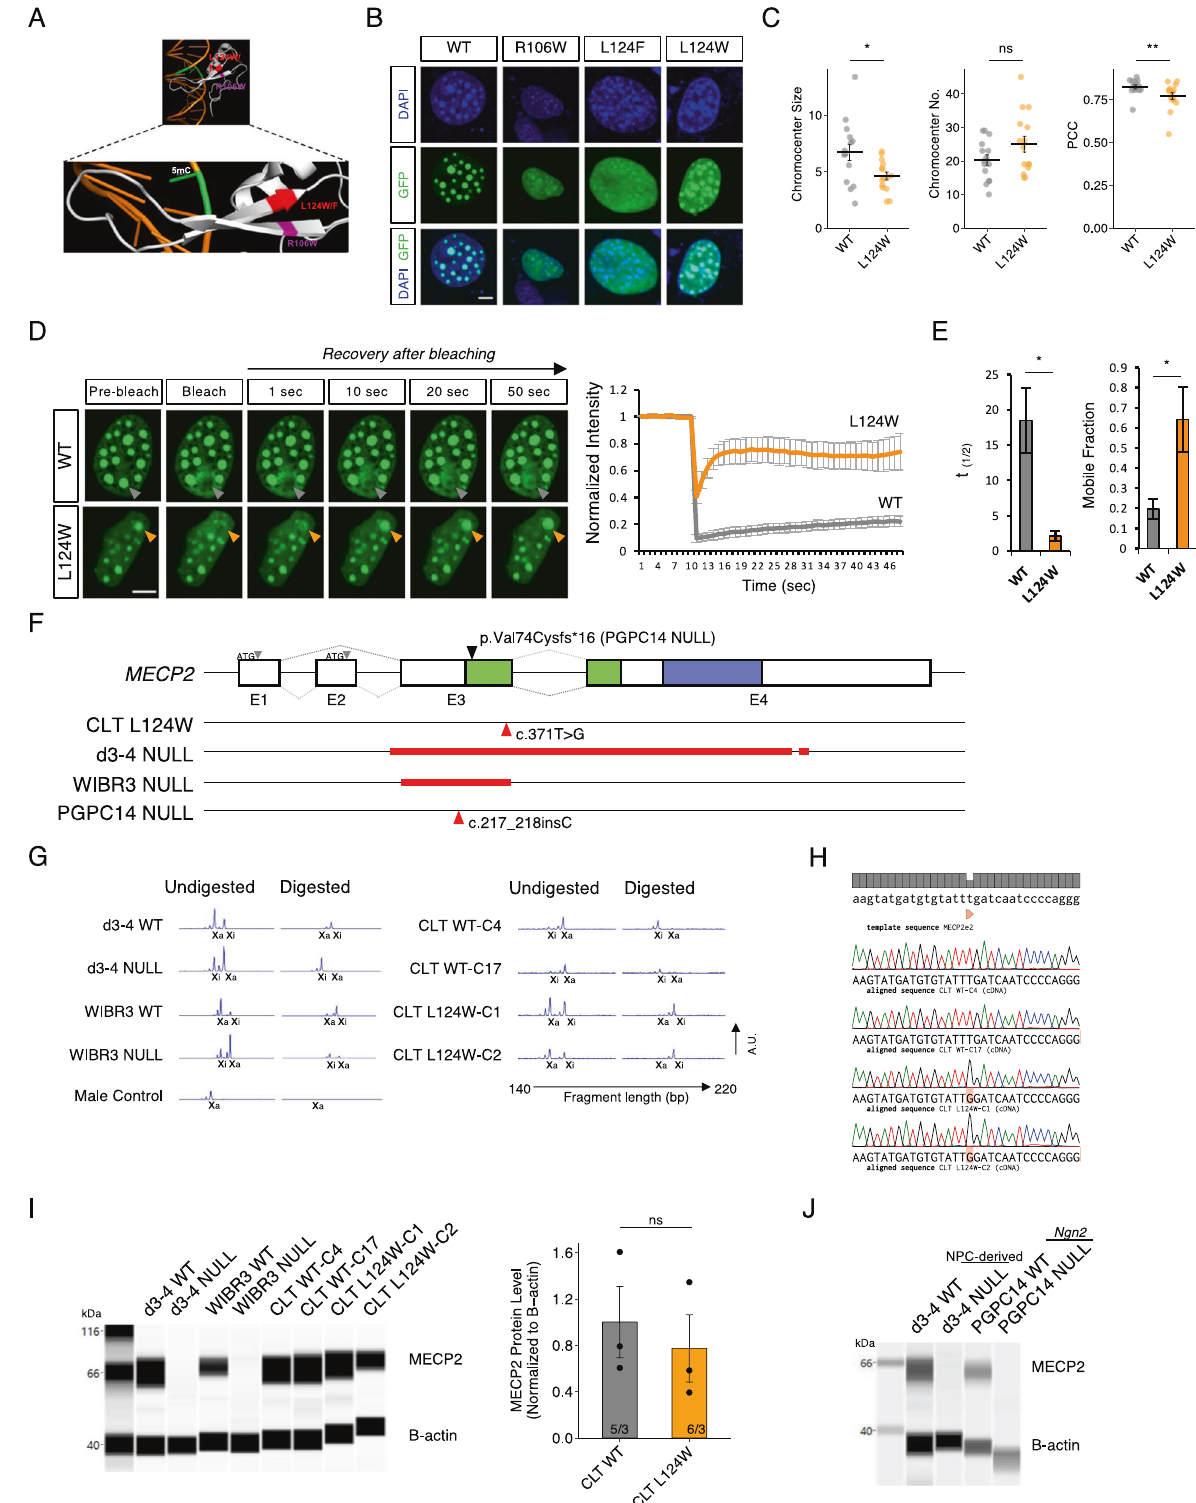
demonstrated pluripotency by positive staining for OCT4, NANOG, SSEA-4 and TRA-1-60 (Fig. S1B), spontaneous differentiation into the 3-germ layers (Fig. S1C) and pluripotent cell expression pro fi les determined by RNA-seq and Pluritest analysis [37] (Fig. S1D). After this continued passage for pluripotency characterization,